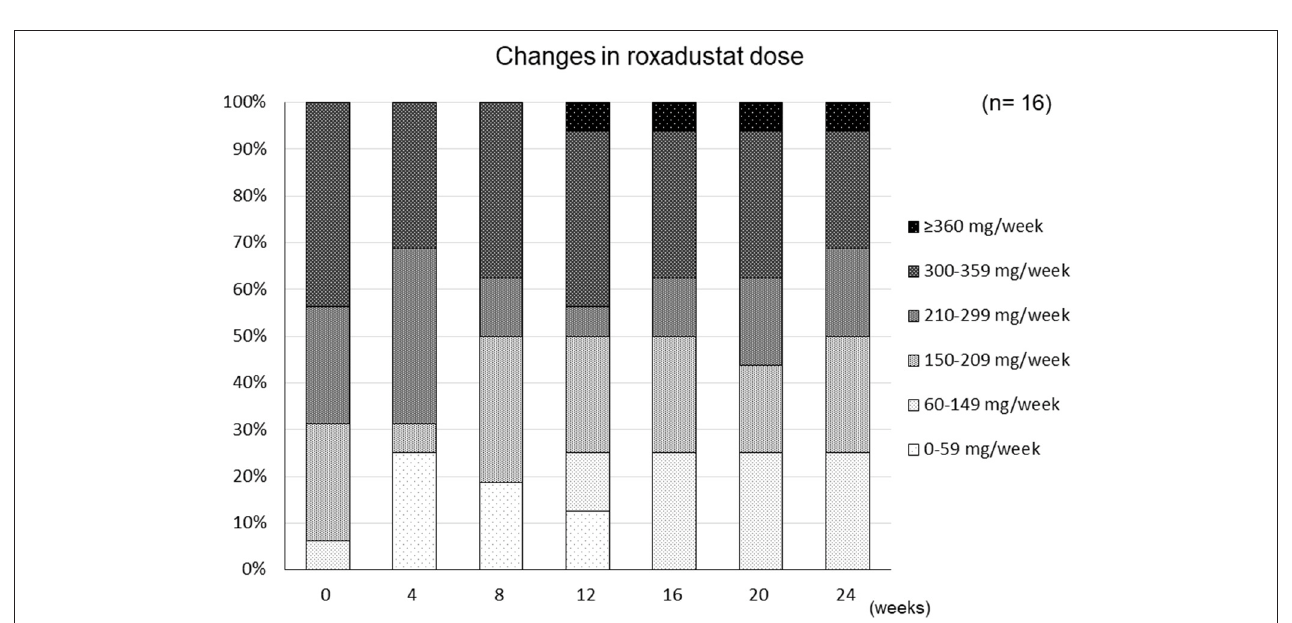
FIGURE 4 | Changes in the distribution of the roxadustat dose administered to participants during the study period.